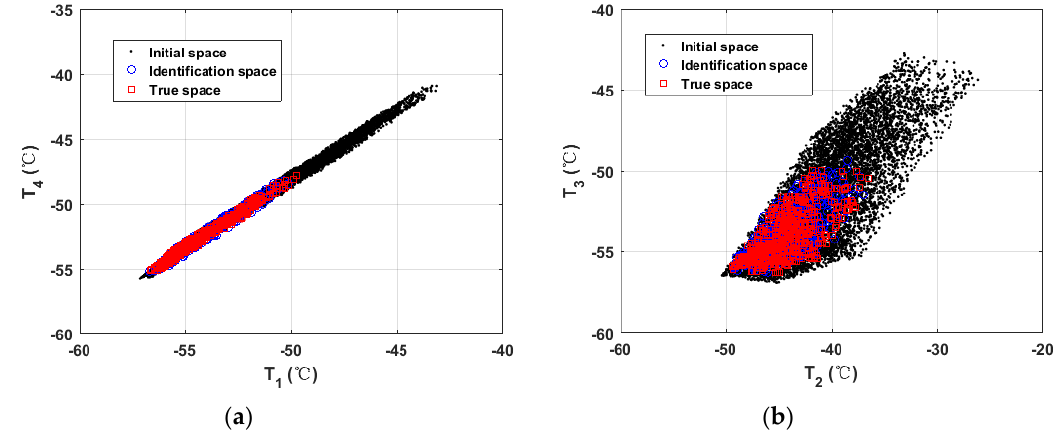
Figure 11. The initial, true, and identification space in the heat transfer system: ( a ) Temperature response T 1 –T 4 ; ( b ) Temperature response T 2 –T 3 .